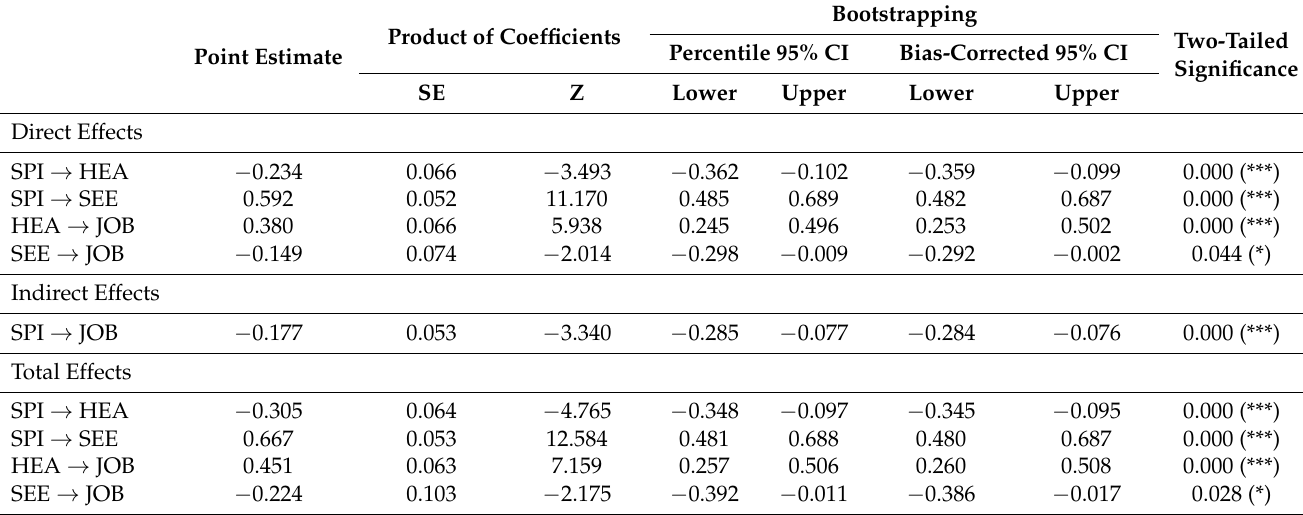
Table 4. Standardized direct, indirect, and total